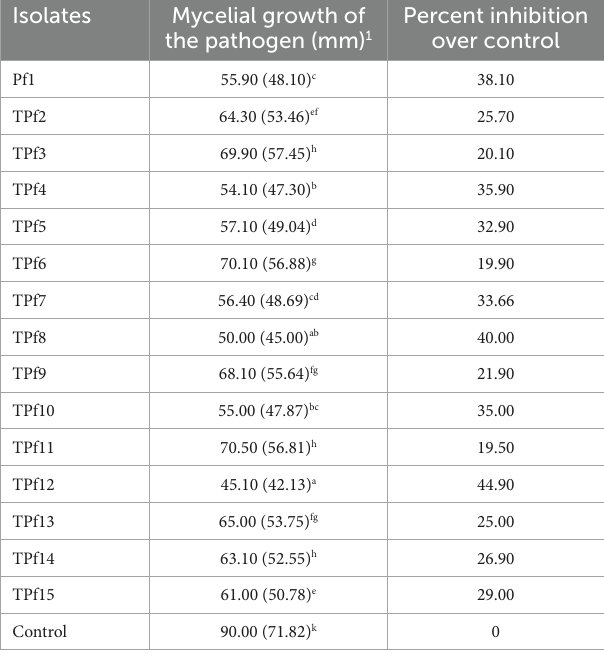
TABLE 1 Antagonistic potential of Pseudomonas fluorescens isolates on FOL under in vitro .